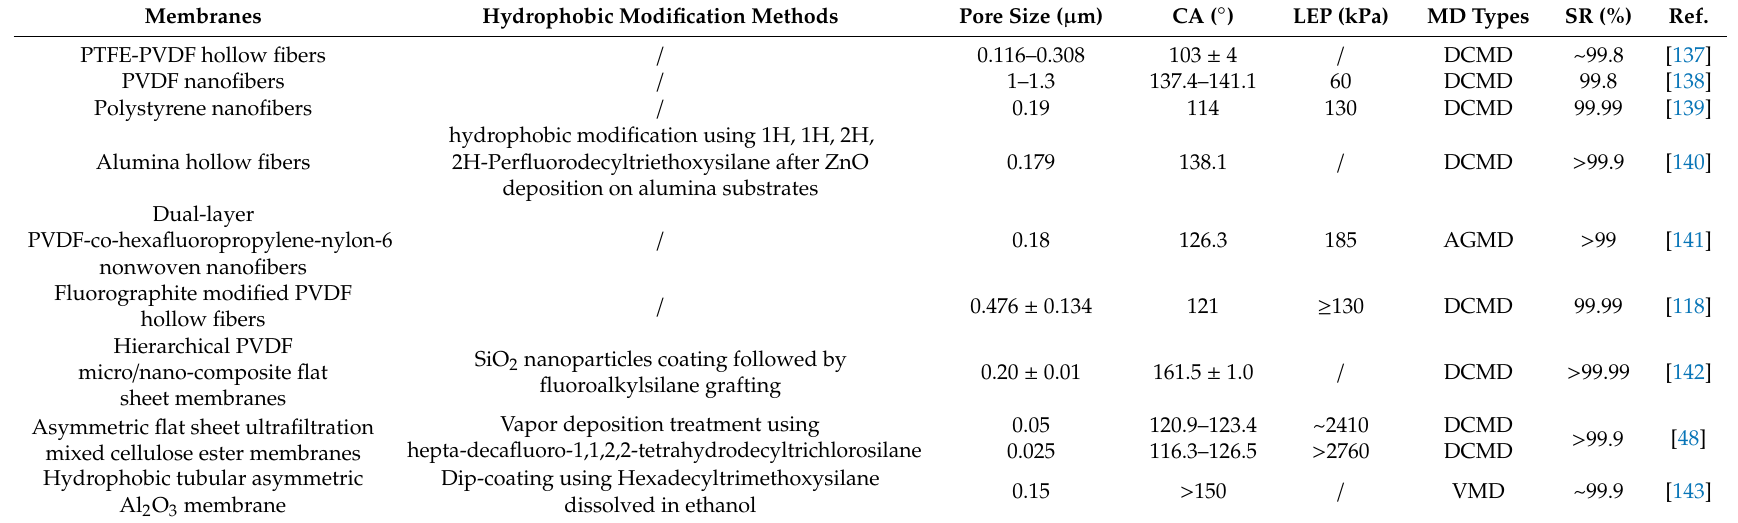
Table 1. Summary of extensively studied hydrophobic membranes in